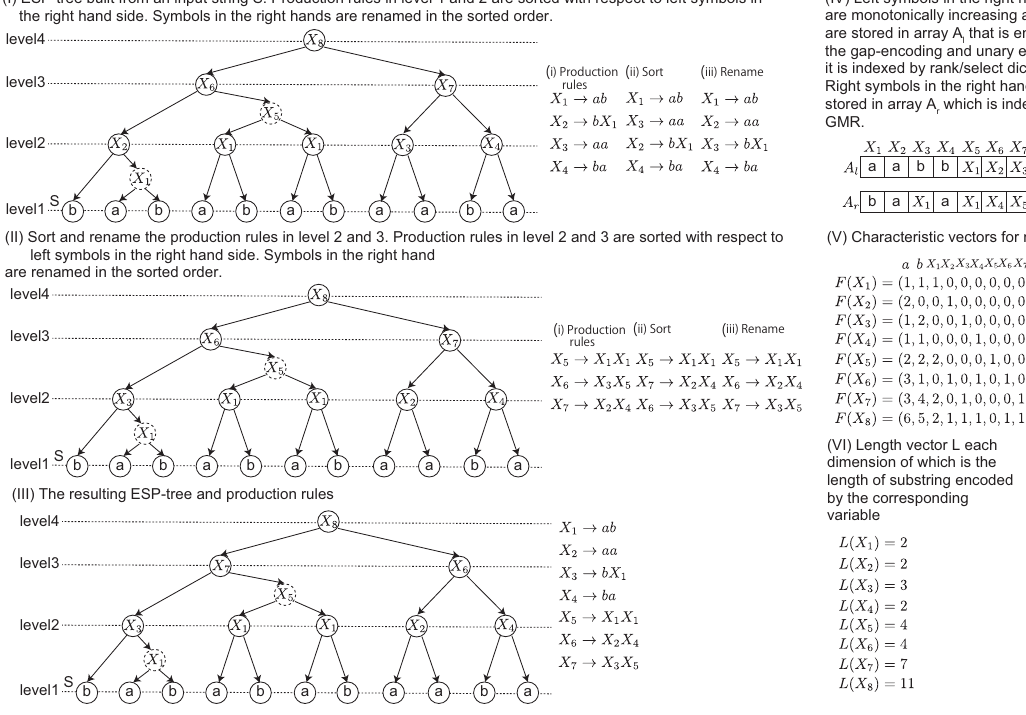
Figure 3. Illustration of encoding